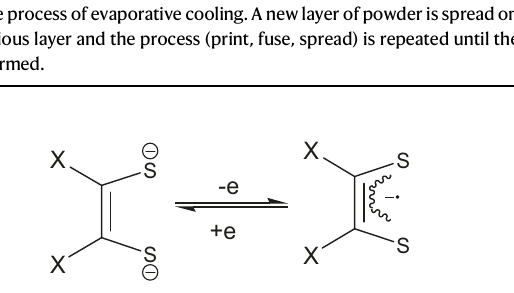
Fig.3|Theredoxreactionofnickeldithiolene. Reductionofnickeldithiolenevia electron transfer reaction that converts it into the mono or dianionic